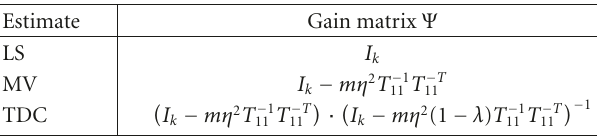
Table 2: Symmetric gain matrix Ψ for UTV and VSV (for the white noise case), using the notation T 11 for either R 11 , L 11 , or S 11 .